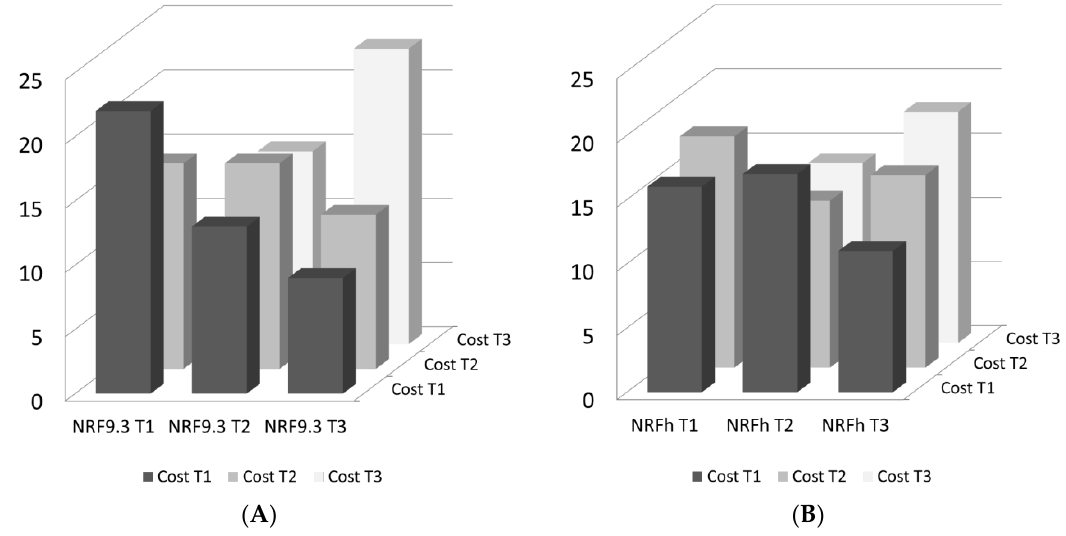
Figure 2. Relation between tertiles of nutrient density per 100 kcal using ( A ) ( right panel ) NRF 9.3 index and ( B ) ( left panel ) NRFh 4:3:3 index and tertiles of cost per 100 kcal.